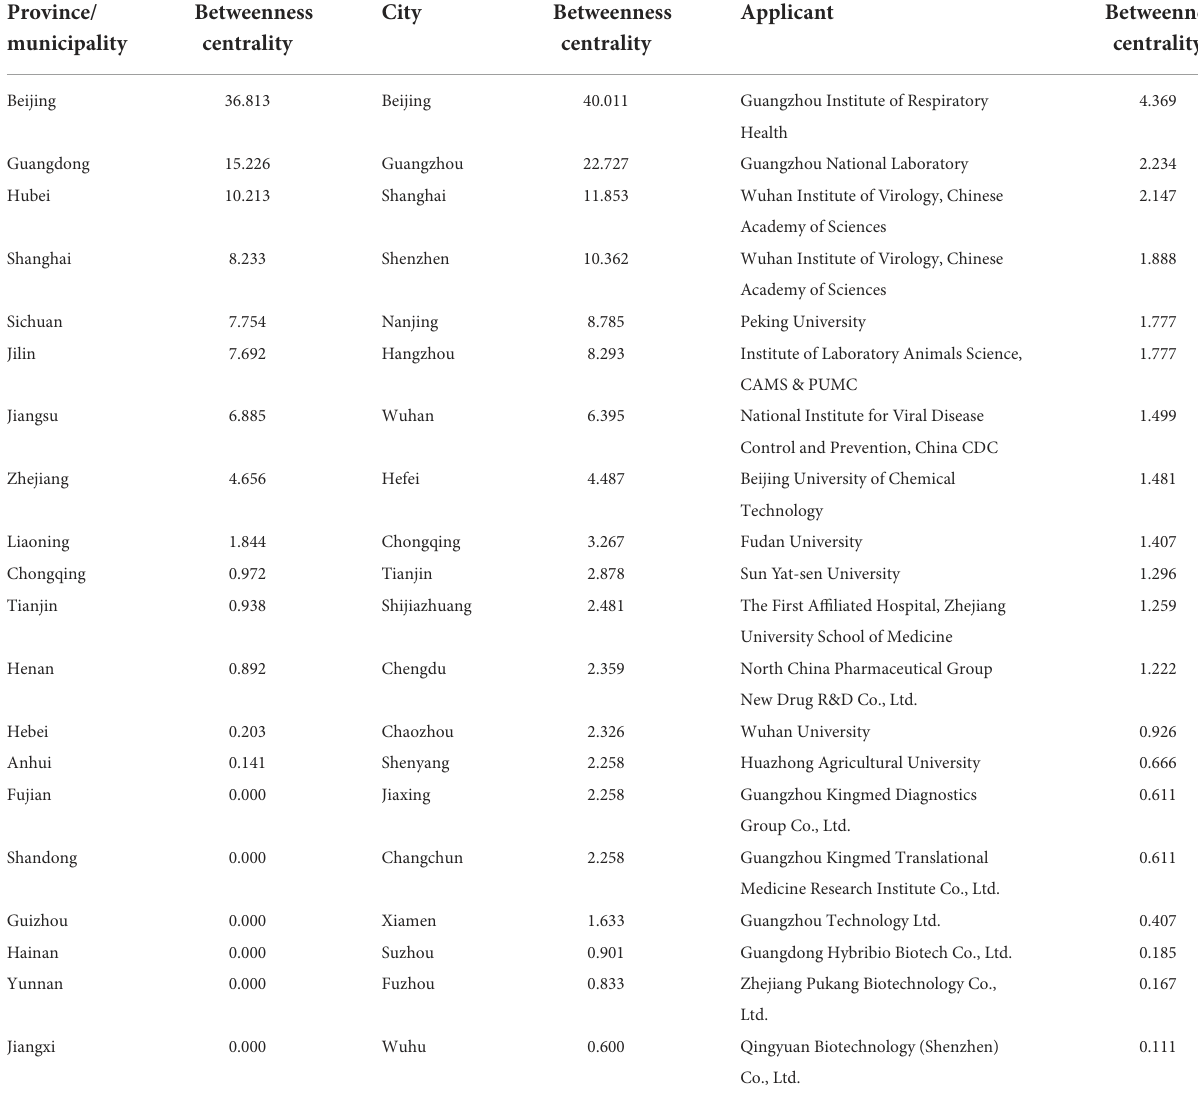
TABLE 3 Betweenness centrality of top 20 nodes in the COVID-19 patent cooperation network. Province/ Betweenness City Betweenness Applicant Betweenness municipality centrality centrality